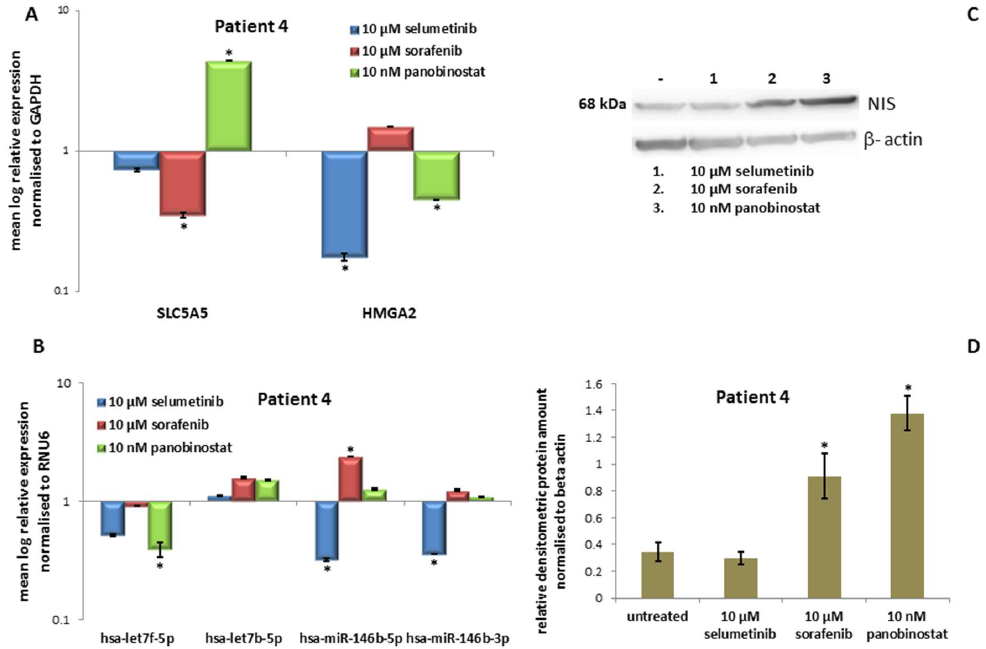
Figure 8. Effects of selumetinib, sorafenib and panobinostat on mRNAs, miRNAs and NIS